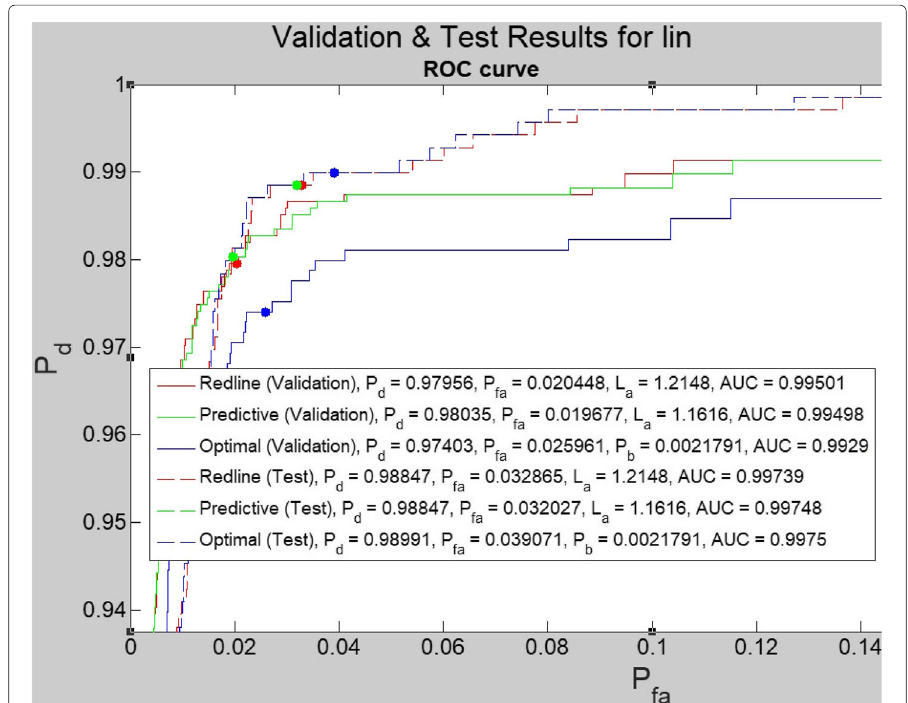
Fig. 9 ACCEPT graphical ROC curve result plot with LIN algorithm in combination with the six detection algorithms on fault case “ventilation fails”. As shown all AUC’s is close to 1. The red, green and blue curves is the ROC curves (solid: validation, dashed: test) and the dots shows the selected trade-off points corresponding to FAR and MDR which relates to the level-crossing threshold giving these performance metrics. Let’s e.g. consider the green PV dot located at (0.032, 0.9885) on the green solid curve meaning FAR=3.2% and MDR=100-98.85=1.15%. The legend tells us that this corresponds to an alarm threshold of L a = 1.1616 and an